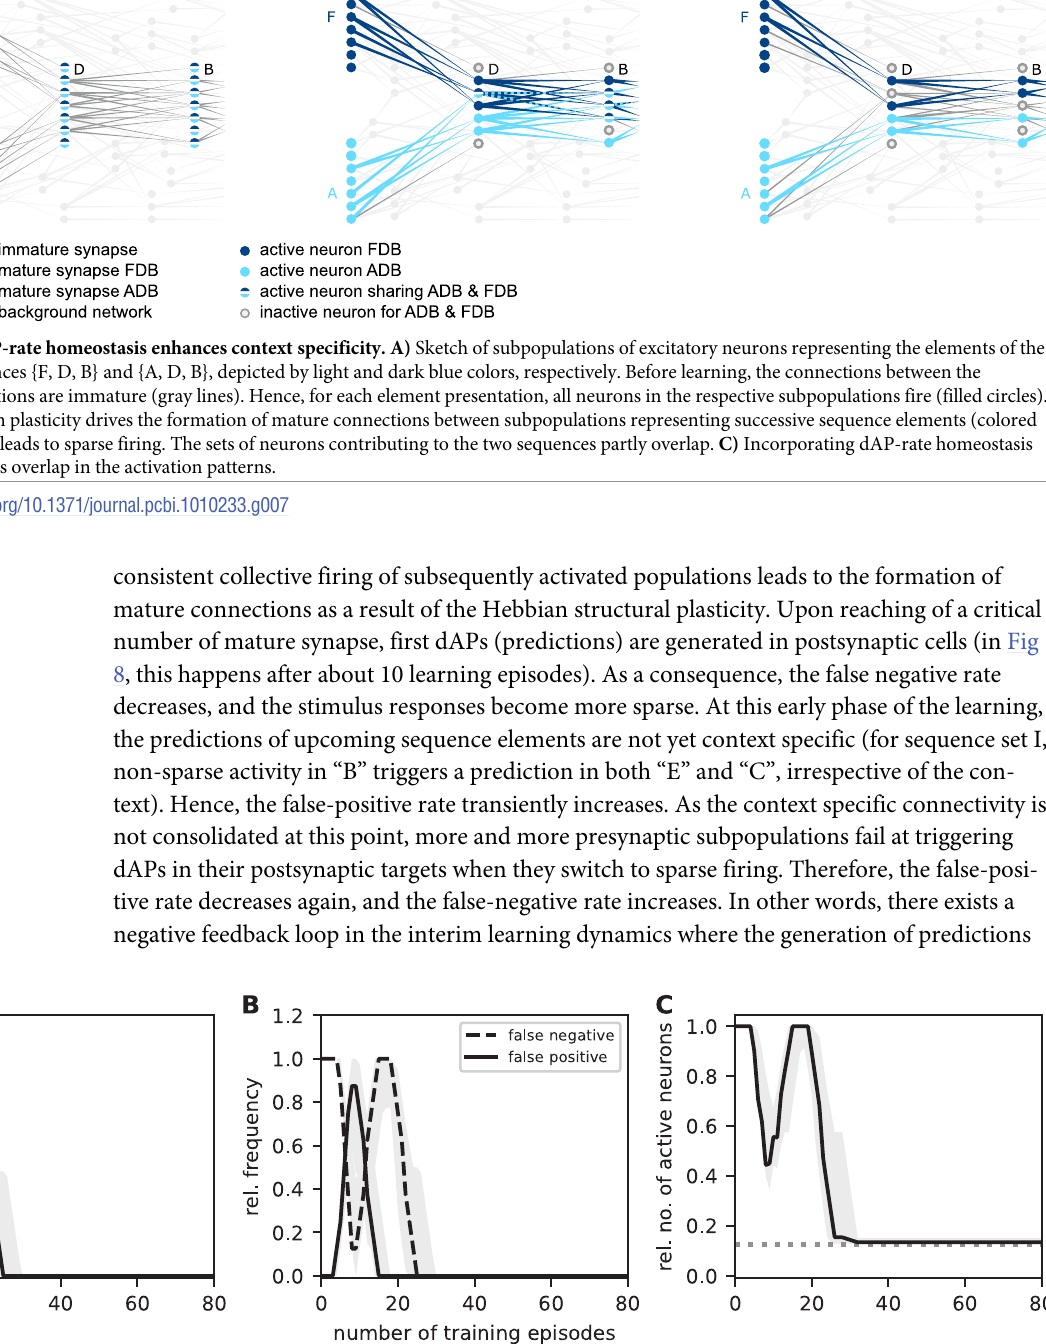
Fig 8. Sequence prediction performance for sequence set I. Dependence of the sequence prediction error ( A ), the false-positive and false-negative rates ( B ), and the number of active neurons relative to the subpopulation size ( C ) on the number of training episodes during repetitive stimulation with sequence set I (see Task and training protocol). Curves and error bands indicate the median as well as the 5% and 95% percentiles across an ensemble of 5 different network realizations, respectively. All prediction performance measures are calculated as a moving average over the last 4 training episodes. The dashed gray horizontal line in panel C depicts the target sparsity level ρ /( Ln E ). Inter-stimulus interval Δ T = 40 ms. See Table 2 for remaining